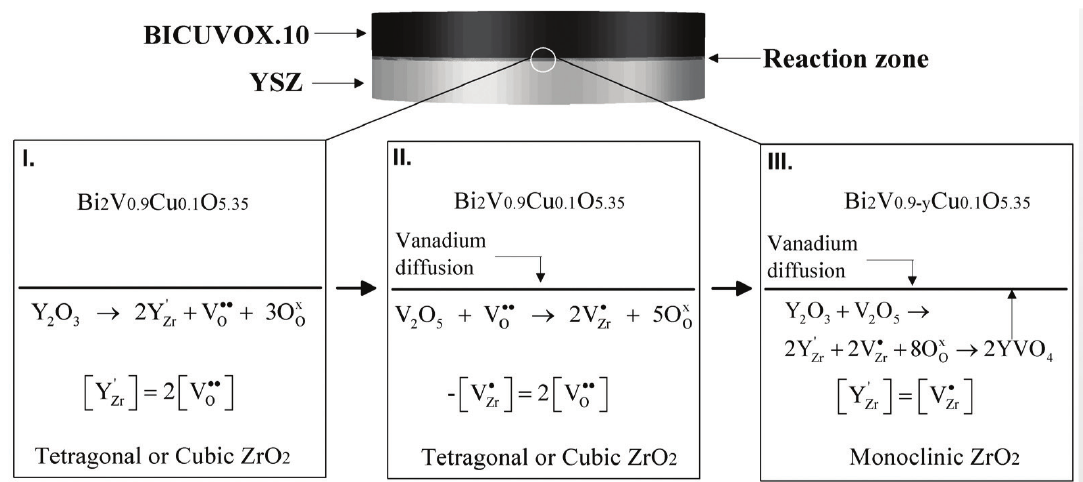
Figure 6. Proposed mechanisms for high-temperature ZrO dopants description mechanism is explained into three main steps. The Kröger-Vink notation for the     � Zr V representation,     � Zr V represents one V 5+ ion replacing the Zr 4+ cation into the ZrO